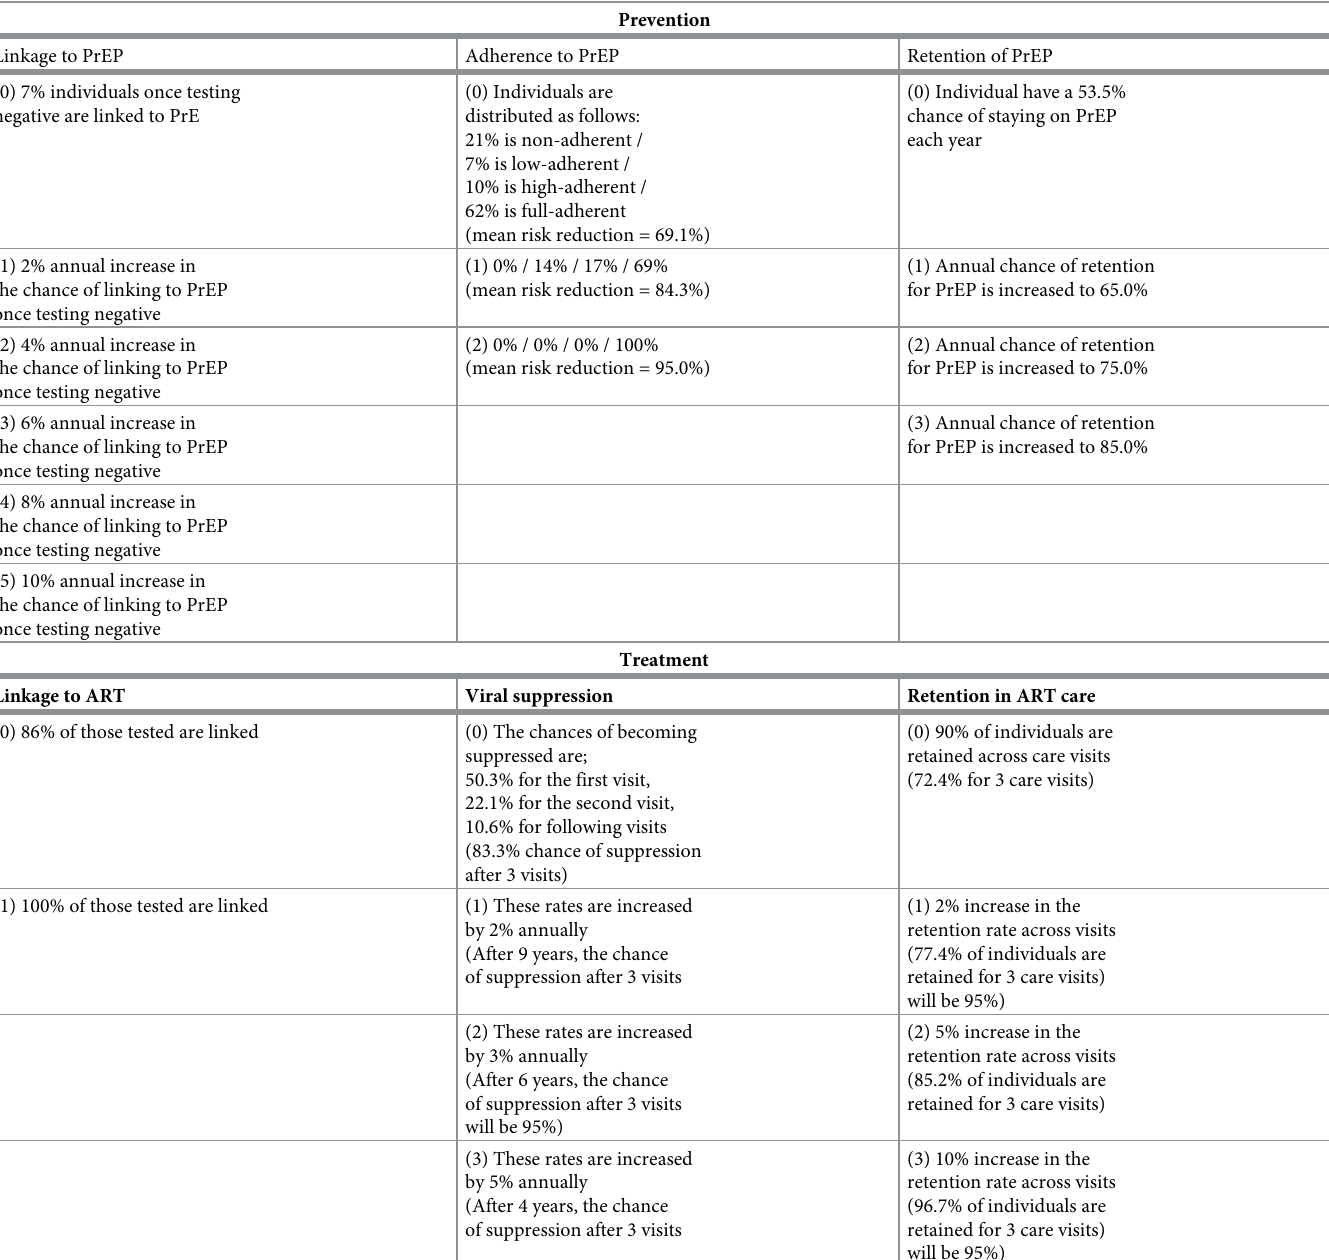
Table 2. Levels of prevention and care levers used in the